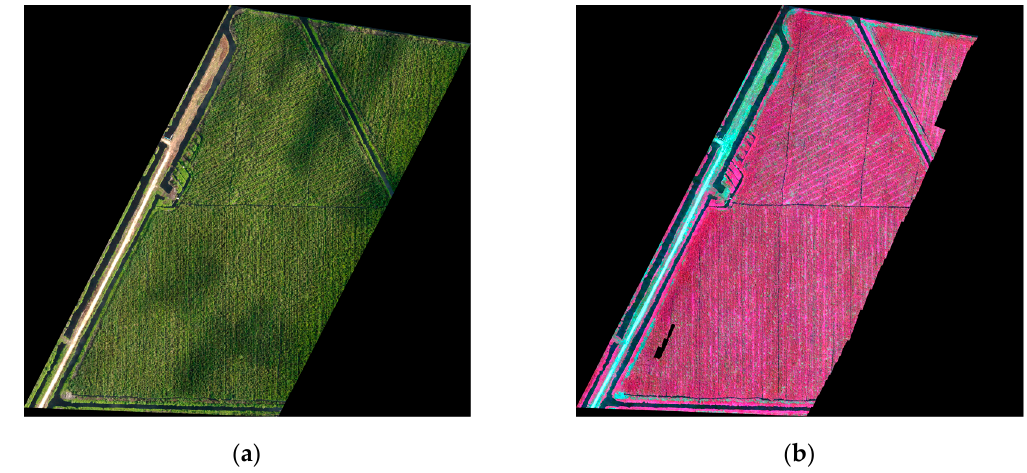
Figure 7. Ortho imagery of the test site for ( a ) the true color composite (RGB) image from the digital camera and ( b ) the false color composite (RGB: NIR, Red and Green) imagery from the multispectral sensor. The resolution is reduced to 0.2 m from the original resolution for visual purposes.